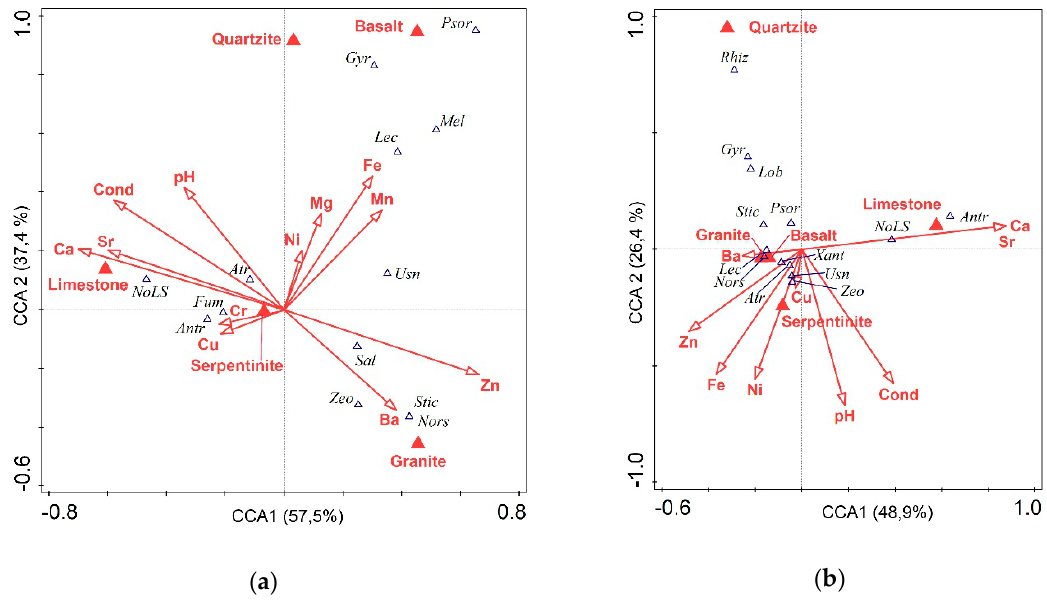
Figure 5. Canonical correspondence analysis (CCA) ordination plot showing the cover of lichens containing di ff erent secondary metabolites in relation to rock types and their chemical properties. ( a ) Foliose and fruticose species, ( b ) Crustose species. Abbreviations of names of the secondary metabolites include the first three or four letters. NoLS—no lichen substances.